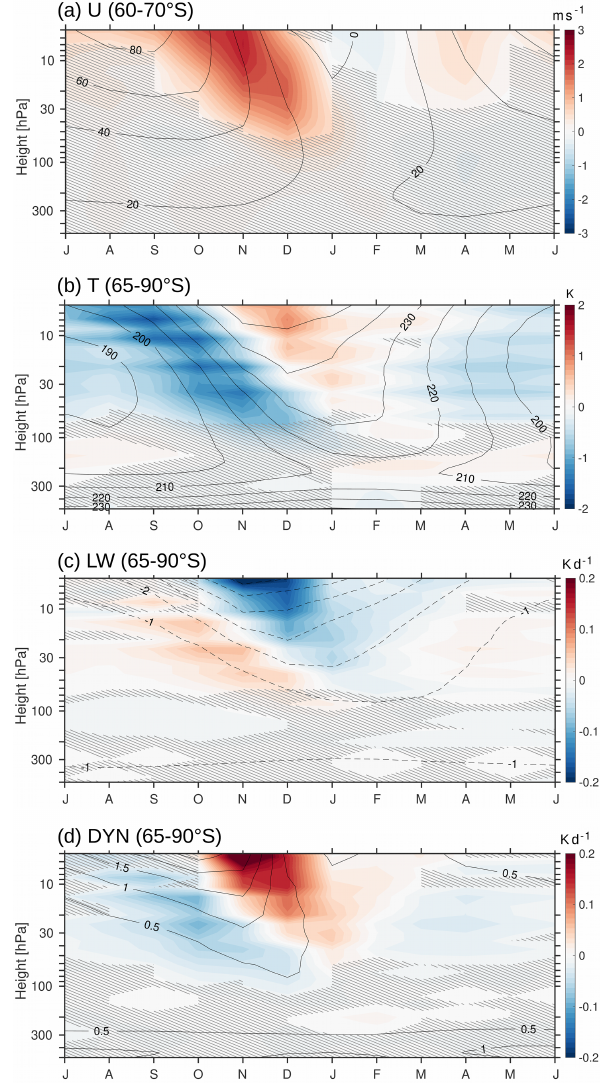
Figure 2. SH ensemble mean differences between Chem ON and Chem OFF for the climatological zonal mean zonal wind ( U ) in meters per second (a) , polar cap temperature ( T ) in kelvin (b) , long- wave heating rate (LW) in kelvin per day (c) and dynamical heating rate (DYN) in kelvin per day (d) as a function of height (shading). Contours represent the climatology of Chem ON. The contour in- tervals are 20ms − 1 (a) , 10K (b) , 1Kd − 1 (c) and 0.5Kd − 1 (d) . Statistically insignificant regions are hatched at the 5% level based on a two-sample t test.